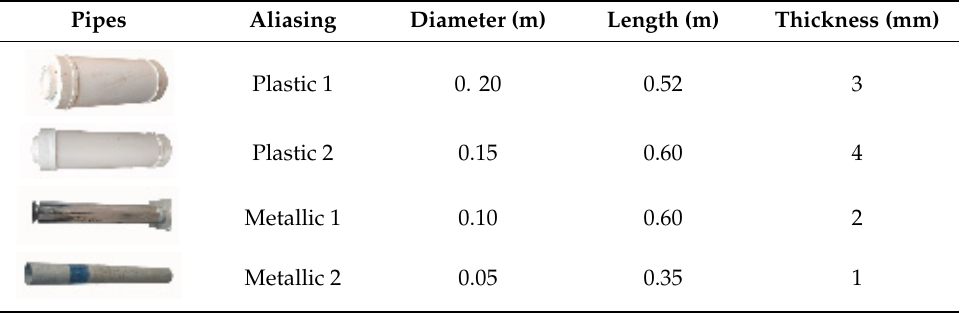
Table 1. Summary of materials, diameters, lengths, and depths employed in the experiment.